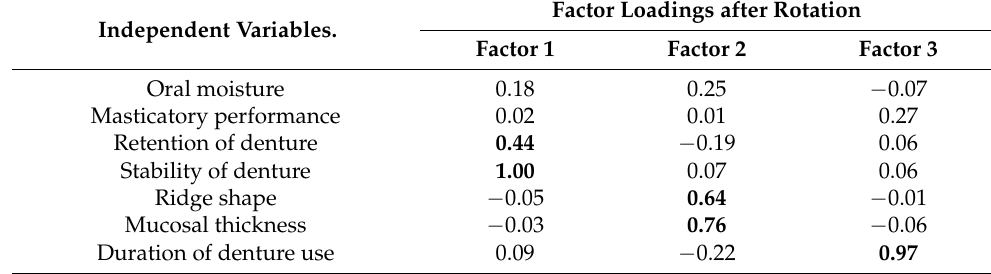
Table 4. Exploratory factor analysis.